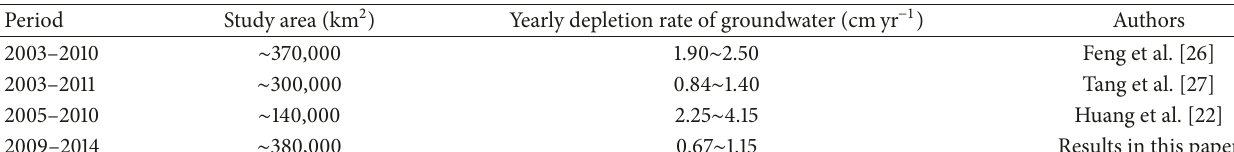
Table 1: Results compared with previous studies in the North China Plain.